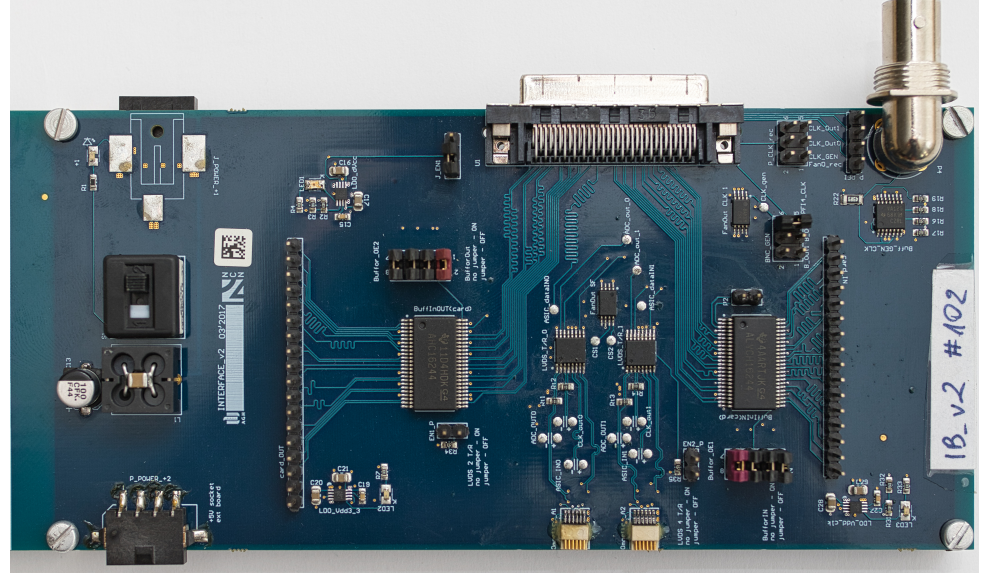
Figure 4. IB photograph. This particular version supports up to two AB and its dimensions are 15cm ×